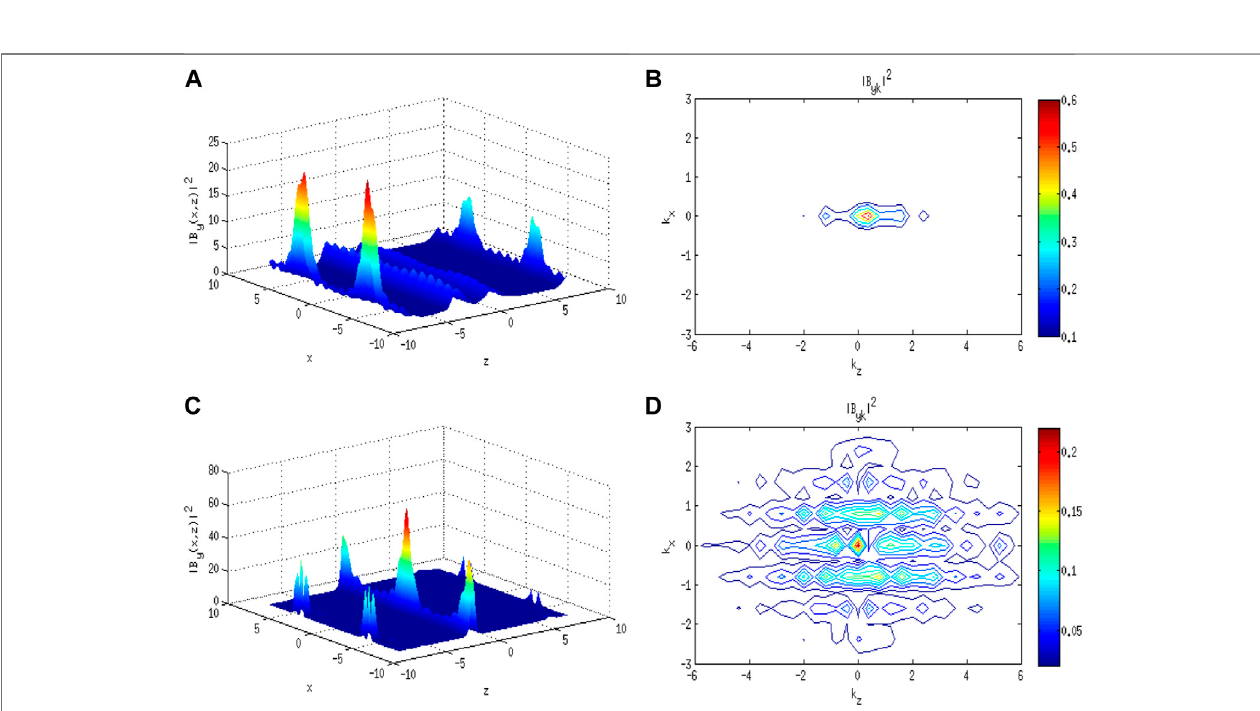
FIGURE 3 | With IC-3. (A) Normalized intensity pro fi le of the KAW magnetic fi eld (| B 2 y | / B 2 n ) at normalized t = 6 (t normalized by t n (cid:2) 2 ω / V 2 A k 2 0 z ) in a normalized x – z plane ( x normalized with x n (cid:2) ρ s and z normalized by z n (cid:2) 2/ k 0 z ). (B) Contours ofnormalized | B yk | 2 against Fouriermodes ofKAWat t=6. (C) Normalized magnetic fi eld intensity pro fi le of KAW at t = 13. (D) Contours of normalized | B yk | 2 against Fourier modes of KAW at t = 13. “ Reproduced from [Gaur et al. (2014), Astrophys Space Sci (2014) 350 , https://doi.org/10.1007/s10509-013-17701], with the permission of Springer Publishing. ”